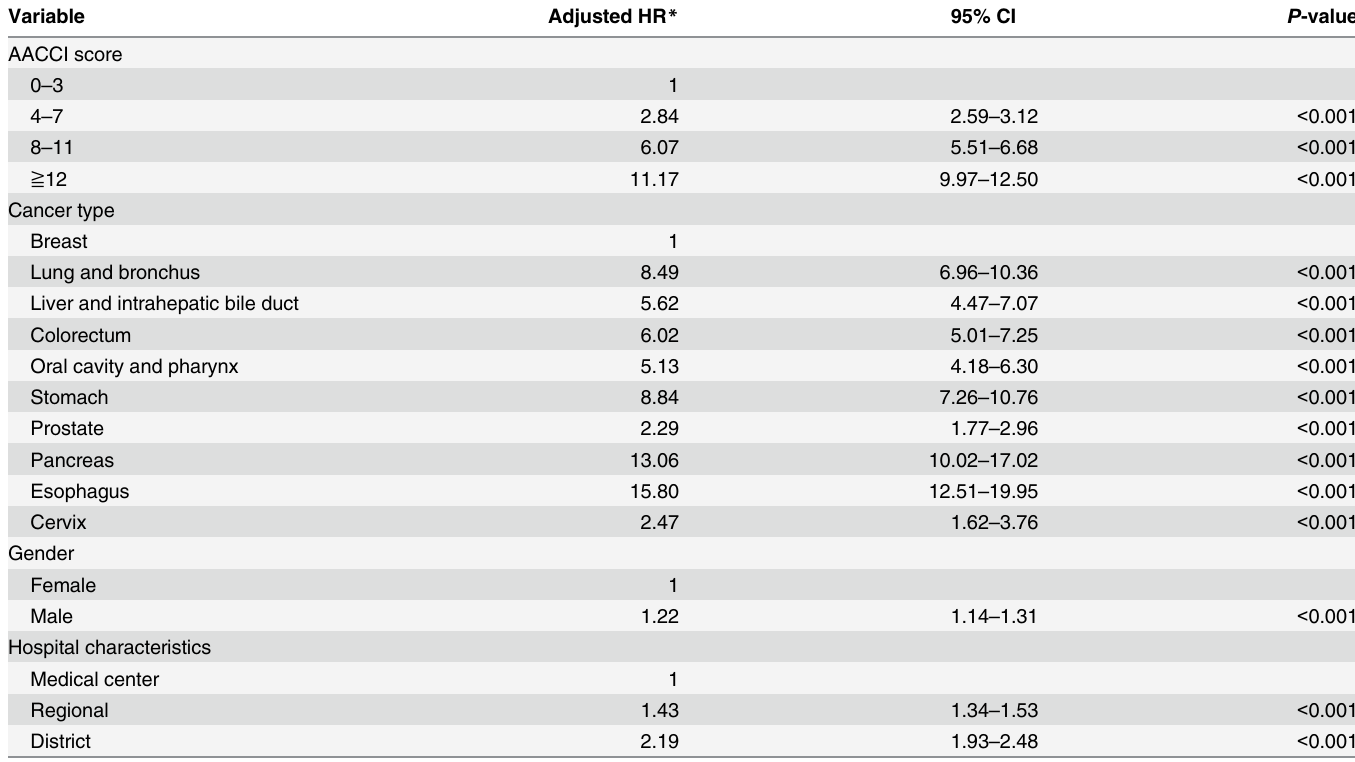
Table 6. Multivariate logistic regression